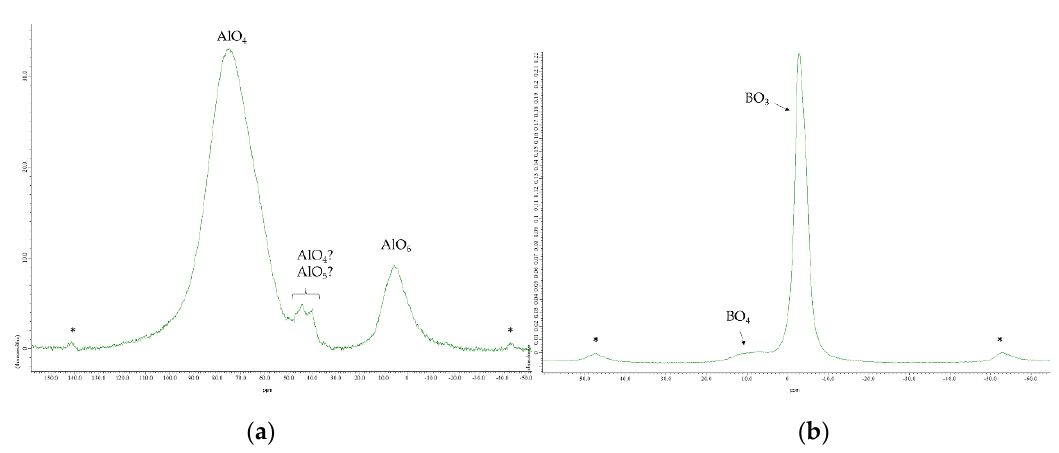
Figure 5. Magic angle spinning nuclear magnetic resonance spectroscopy ( NMR MAS) spectra of waterglass containing phosphate hardener; spinning sidebands are marked with *; ( a ) 27 Al MAS spectrum of waterglass containing AlPO 4 hardener, MAS spinning frequency: 12 kHz, resonance frequency: 130.3 MHz, 250 scans; ( b ) 11 B MAS spectrum of waterglass containing BPO 4 hardener, MAS spinning frequency: 8 kHz; resonance frequency: 160.4 MHz, 444 scans.